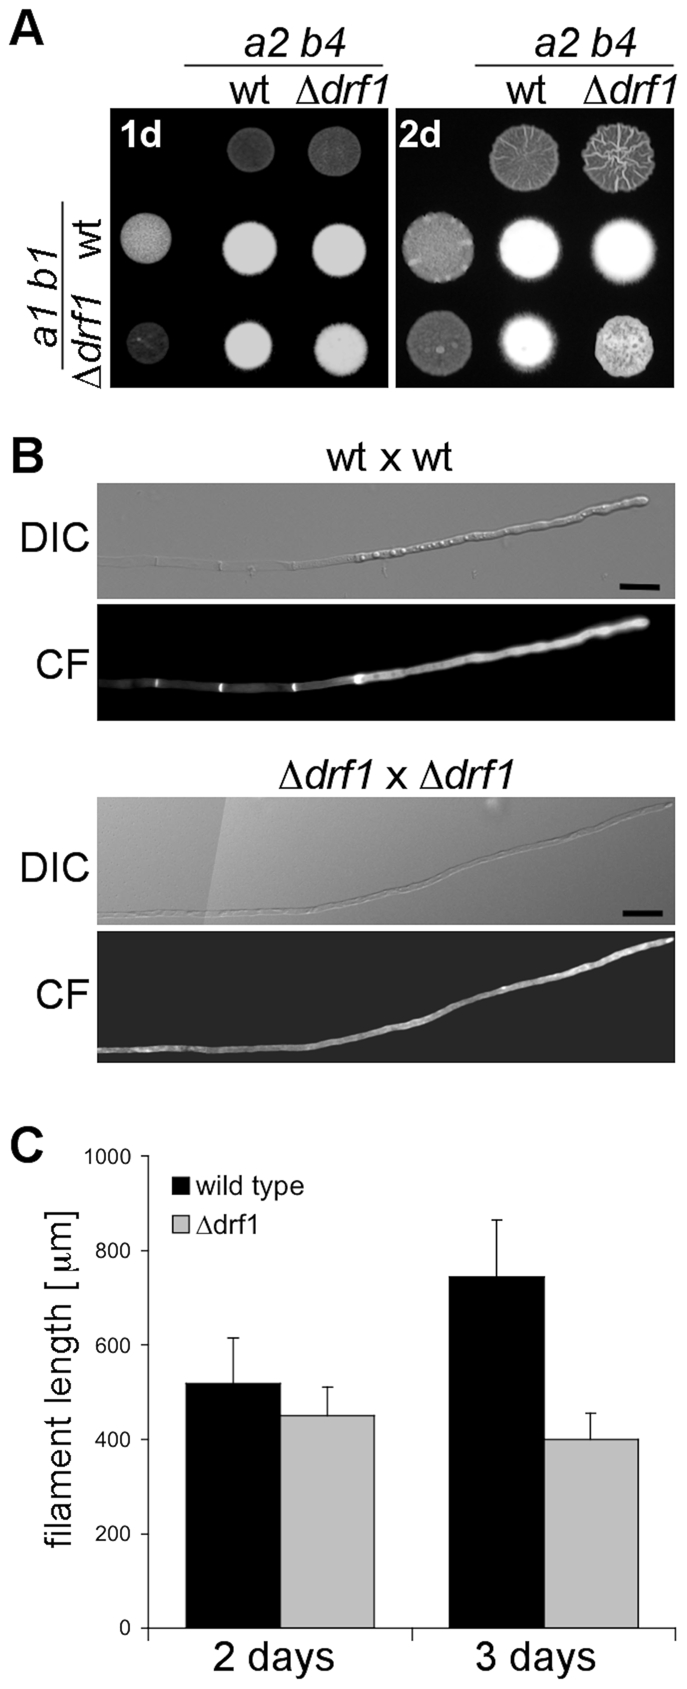
Filaments of drf1 mutants do not form retraction septa.A: The indicated haploid strains were spotted either alone or in combination on charcoal-containing medium. White colonies are indicative for the formation of aerial hyphae. Filamentous growth was analyzed one (1d) and two (2d) days after spotting the respective strains. B: Two-day-old filaments formed by the indicated crossings were stained with calcofluor white (CF; lower panel). The respective brightfield image is shown (upper panel). Filaments of drf1 deletion strains lack retraction septa. To depict more than 180 µm of the growing filament it was necessary to combine two images (Scale bars: 15 µm). C: Quantification of filament length. Using the same strains as in B, filament length was calculated using ImageJ. For each strain and time point 30 filaments were analyzed. Error bars indicate standard deviation.